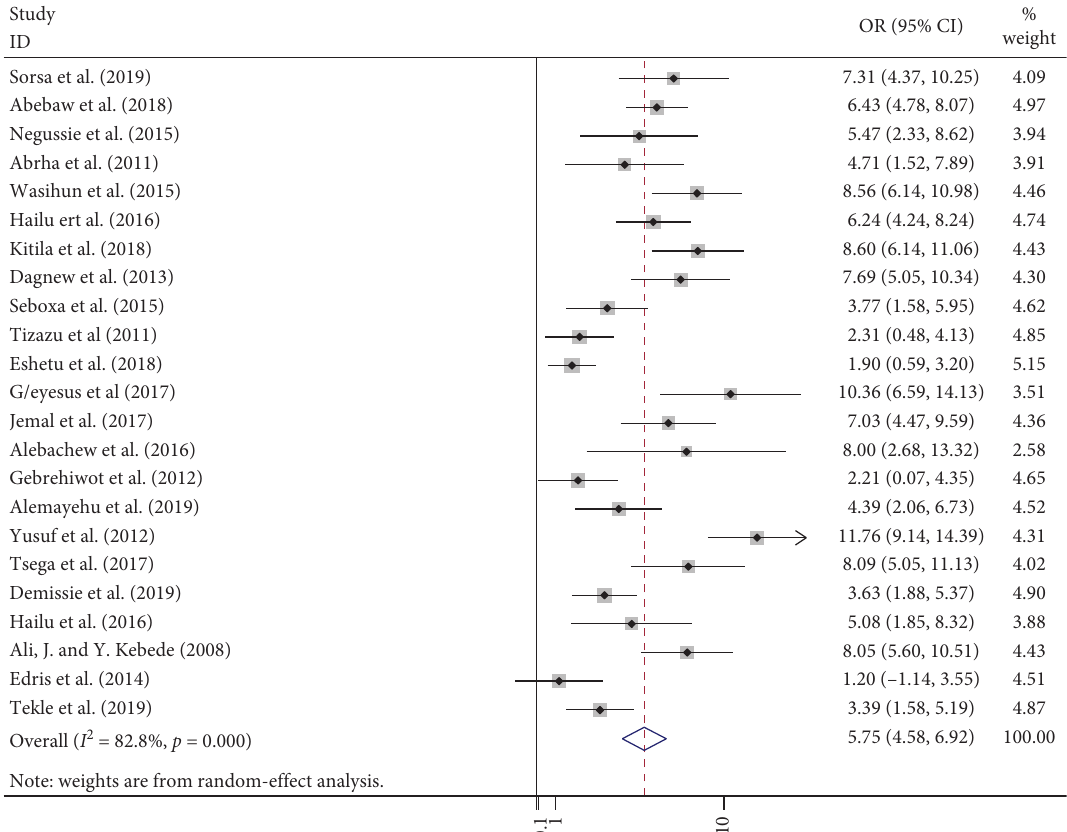
Overall ( I 2 = 82.8%, p = 0.000)